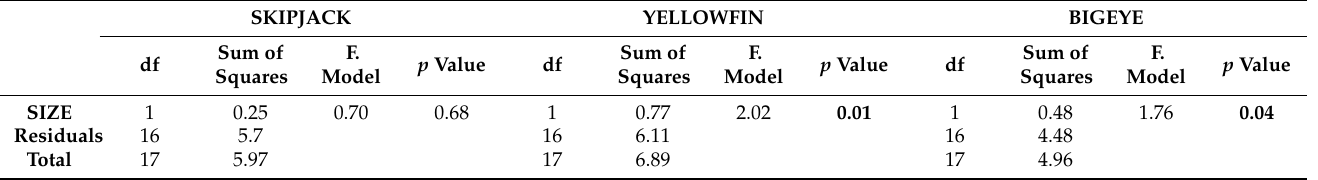
Table 2. Results of permutational ANOVAS (PERMANOVA, 999 permutations) performed on Bray-Curtis dissimilarity matrices to test the variation of bacterial community composition with respect to the size of the three tuna species. Bold values indicate a significant effect of the tested factor ( p < 0.05).